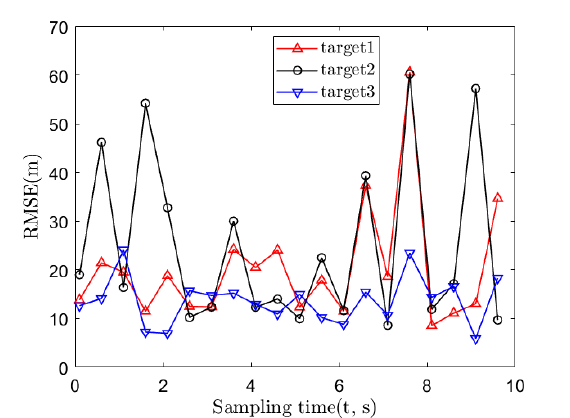
Figure 5. The localization error of the three